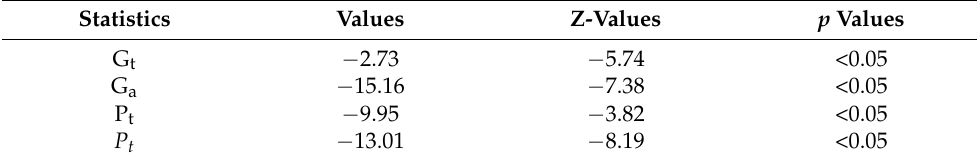
Table 7. Westerlund panel cointegration test.